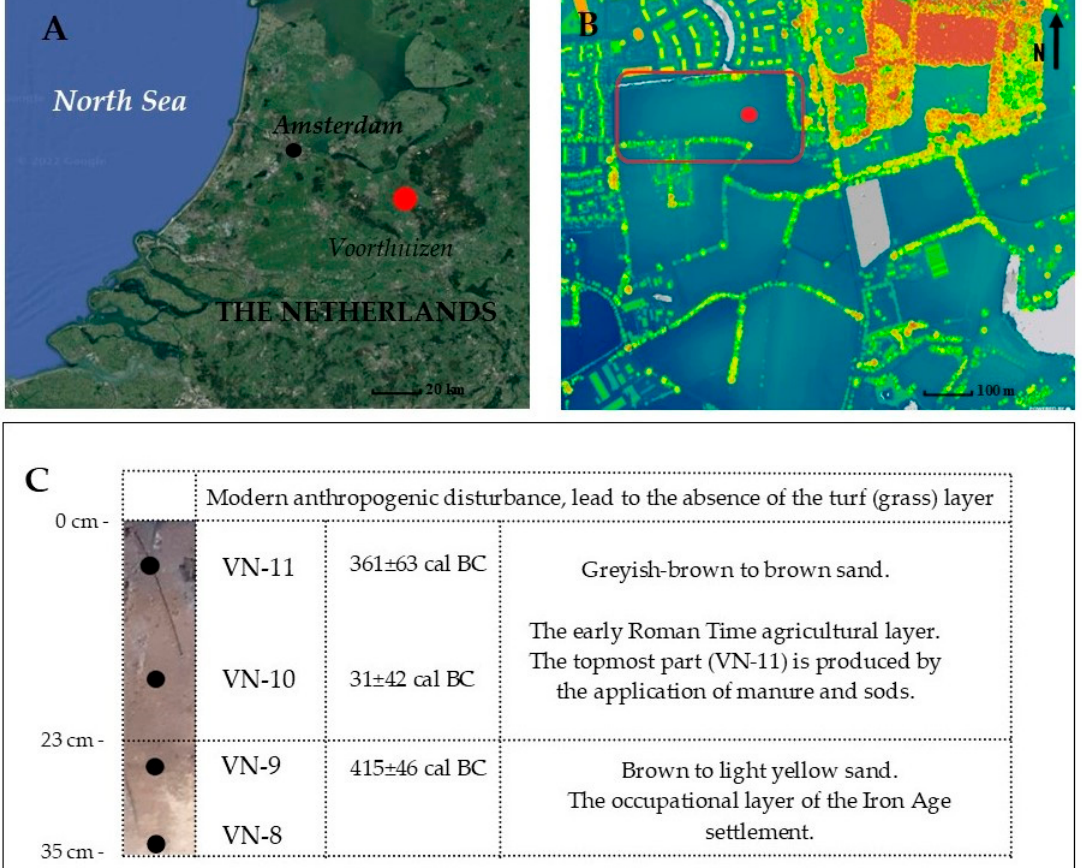
Figure 1. ( A ) Location of Voorthuizen in The Netherlands. ( B ) Northern part of the excavated area in Voorthuizen and the location of the profile, where samples VN-8–VN-11 were taken. ( C ) Profile of the Voorthuizen cultural layer and sampling sites.